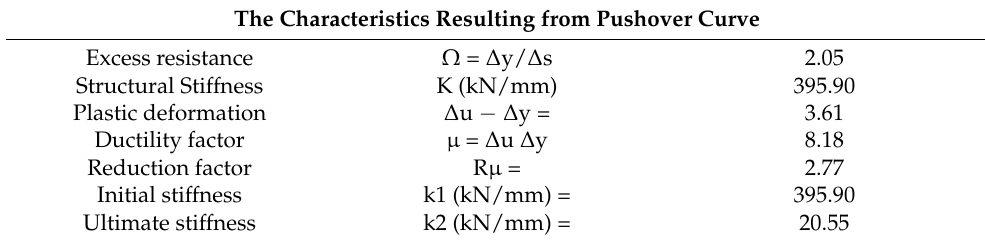
Table 2. The characteristics resulting from pushover curve for frame. The Characteristics Resulting from Pushover Curve